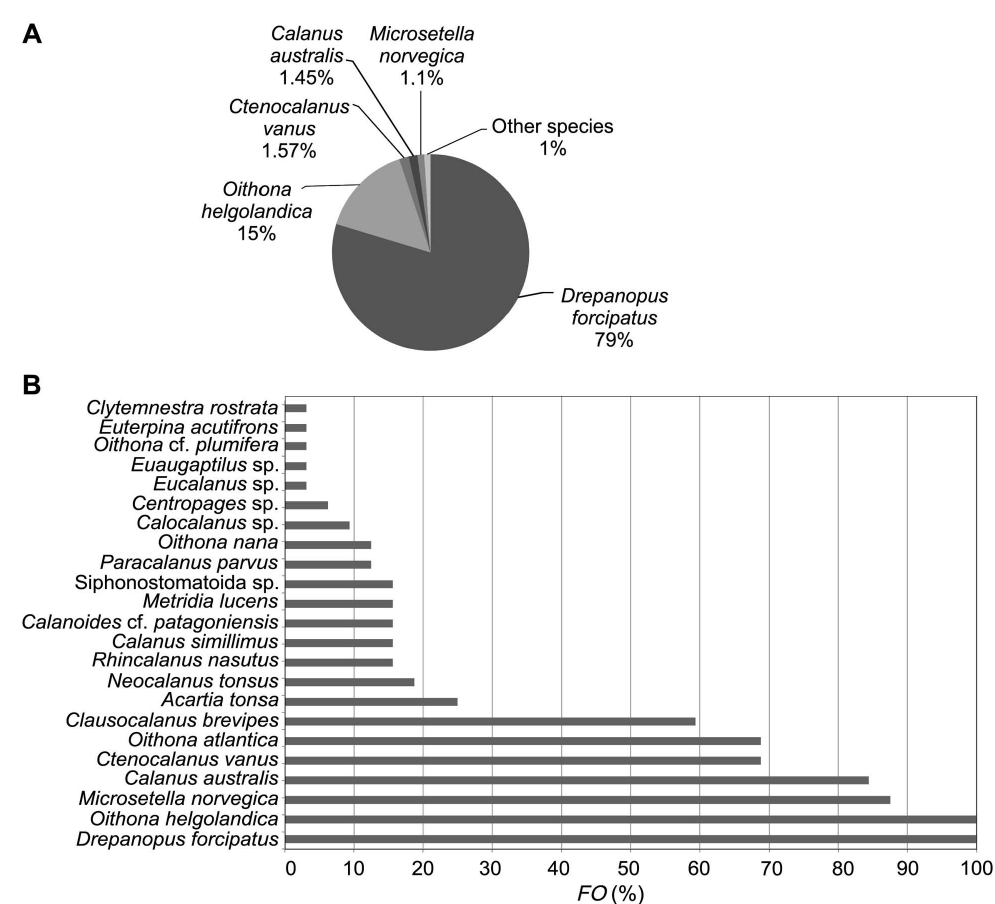
Fig. 2. – Relative abundance (A) and frequency of occurrence (B) of copepod taxa. In (A), Other species includes the rest of the copepod taxa with low relative abundance and frequency of occurrence listed in Table